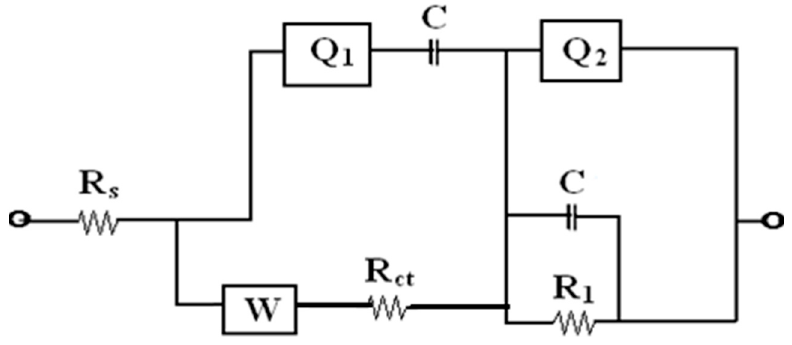
Figure 12. Equivalent circuit for Nyquist plot of samples A, B, C, D and E.